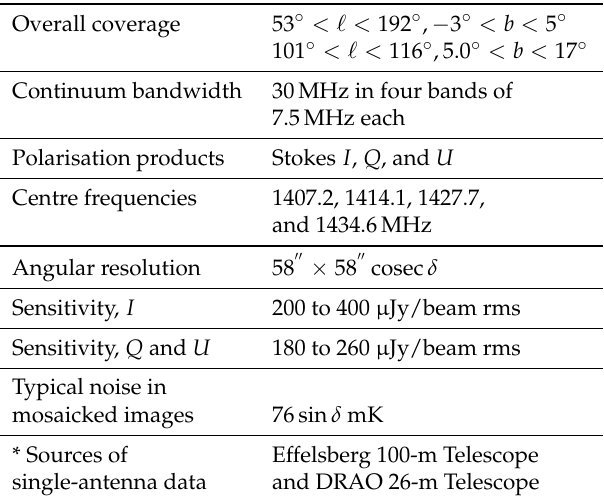
Table 1. The CGPS polarisation